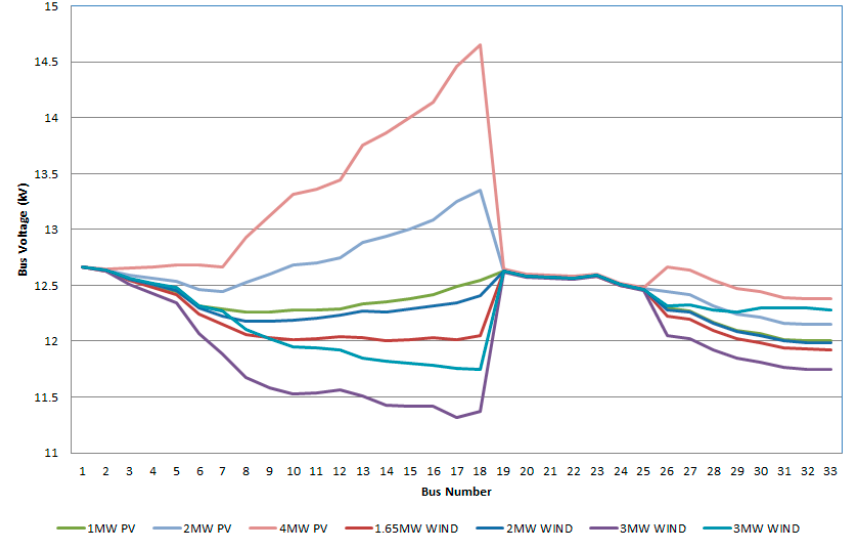
Figure 5. Voltage profiles of network buses when different DG unit sizes have been connected at bus 18.